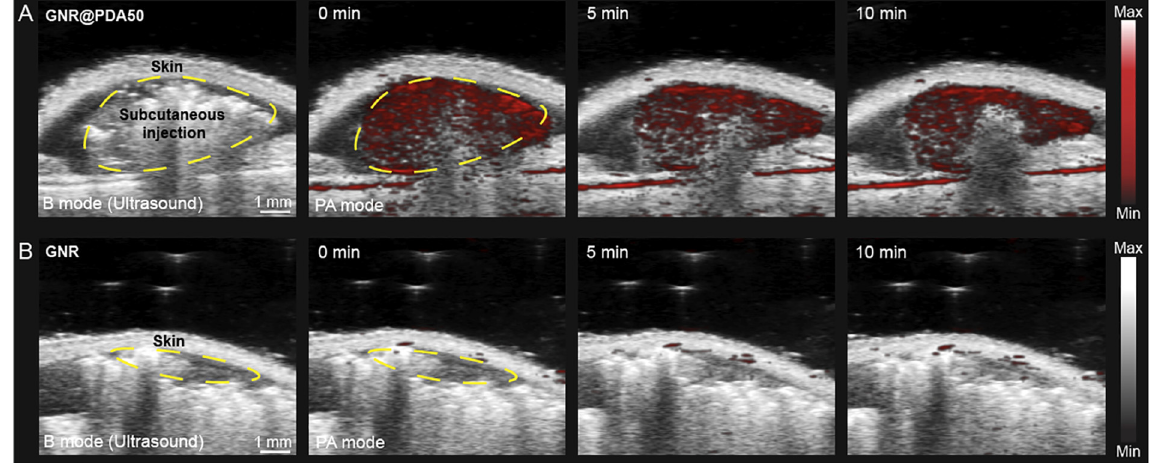
Figure 15. ( A ) PA images with Au nanorods@PDA as exogenous contrast; ( B ) PA images with Au nanorods as exogenous contrast. Reprinted (adapted) with permission from [170]. Copyright 2021 American Chemical Society.